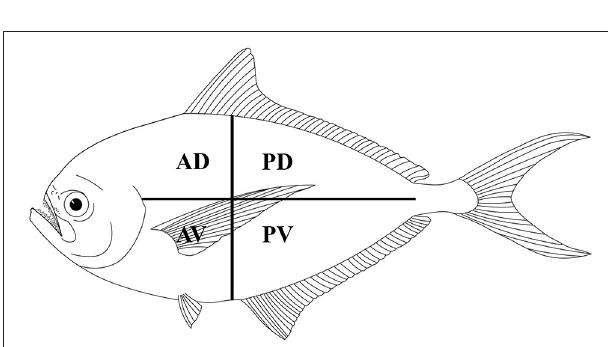
FIGURE 2 | Schematic distribution of Gymnorhynchidae larvae in four muscle sections of the Atlantic pomfret. AD, anterior-dorsal; PD, posterior-dorsal; AV, anterior-ventral; PV,